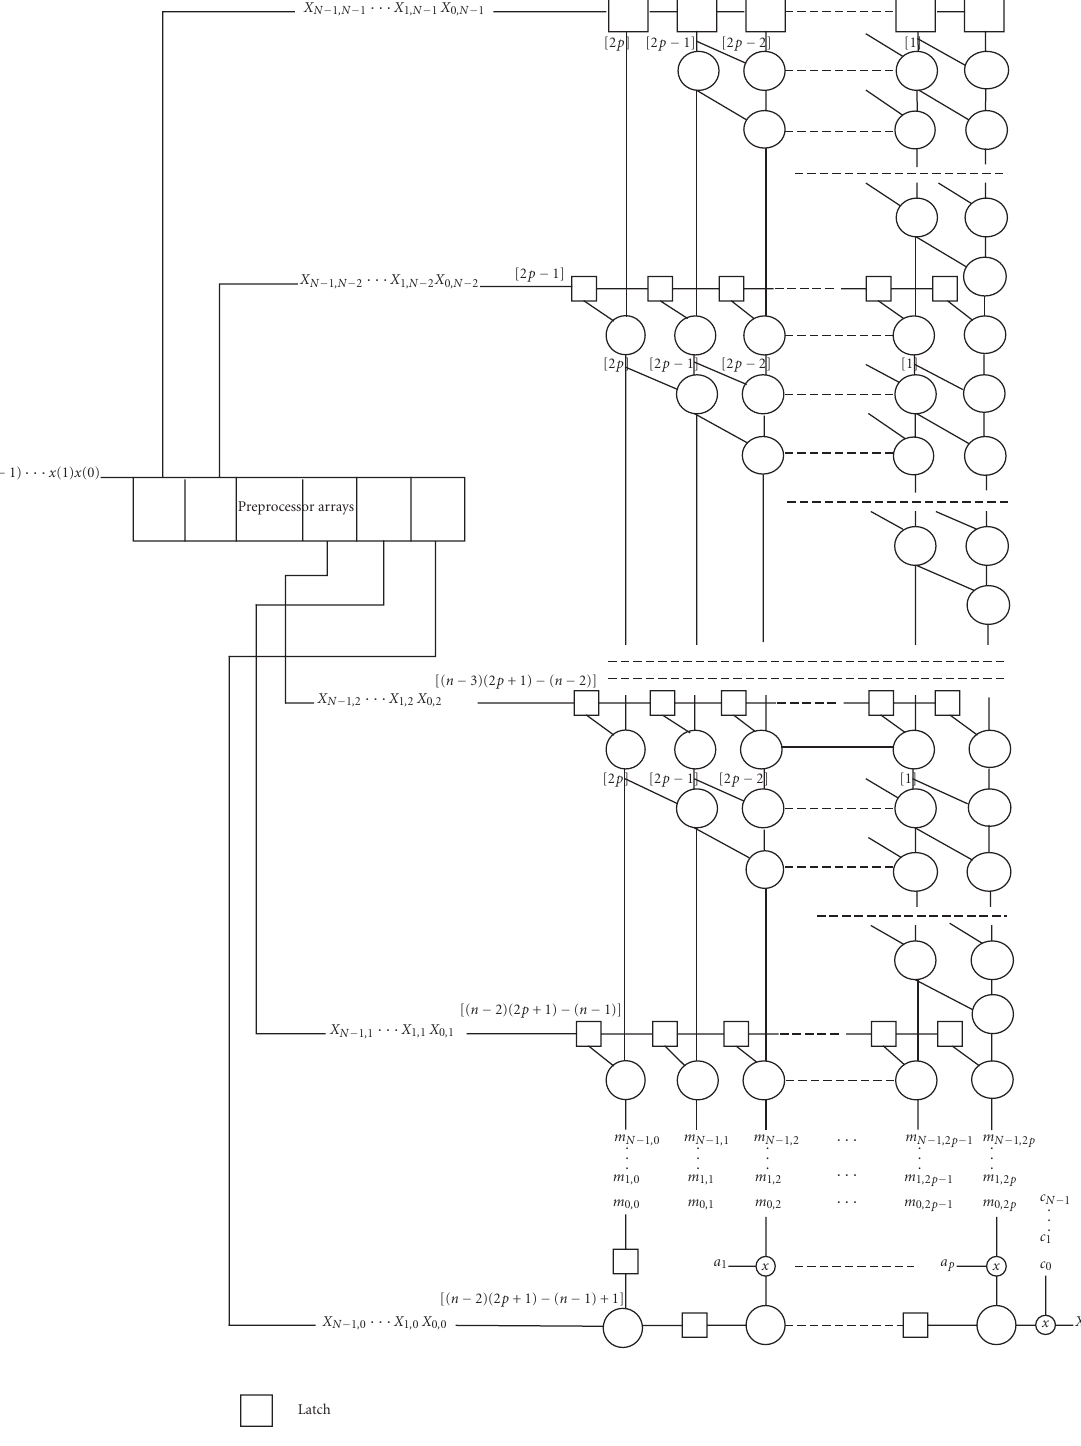
Figure 2: The systolic array for 1D